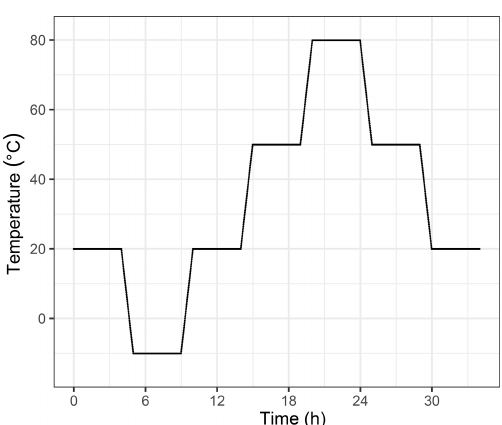
Figure 3. Temperature cycle set at the climate